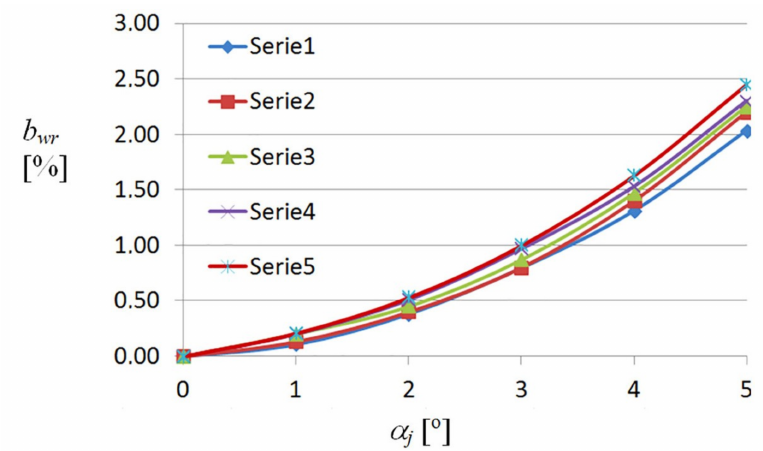
Figure 25. Non-linear relationships between the b wr relative width increments of the fold’s crosswise ends and α j unit angle obtained for various heights of the experimental shell folds: Serie1—50